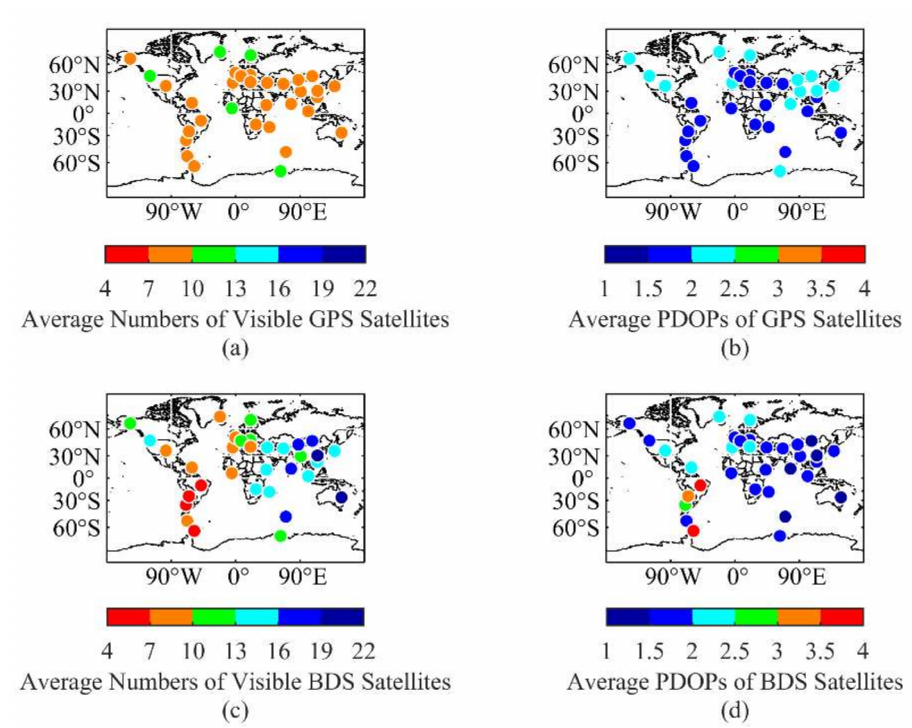
Figure 2. Average number of visible satellites and average PDOP values for GPS and BDS in January 2021 with a cut-off elevation of 10 ◦ . ( a ) Average numbers of Visible GPS satellites; ( b ) Average PDOPs of GPS satellites; ( c ) Average numbers of Visible BDS satellites; ( d ) Average PDOPs of BDS